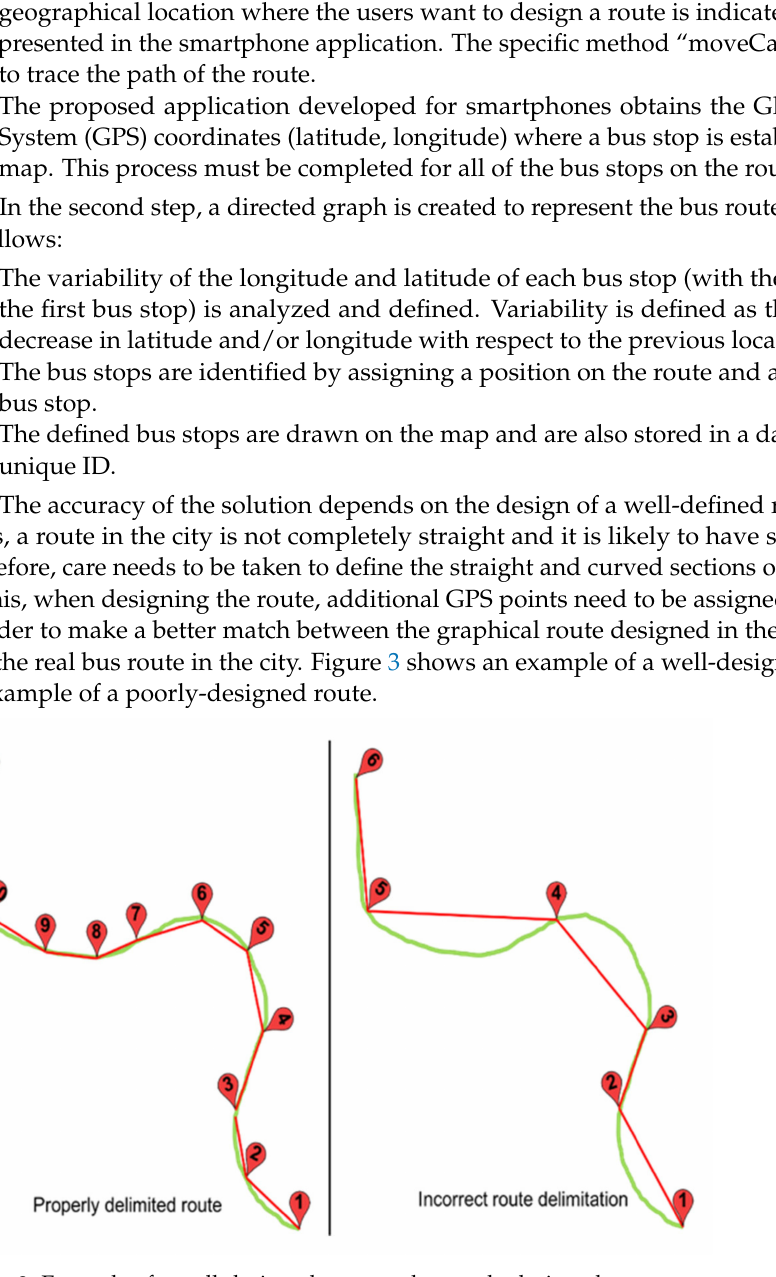
Figure 3. Example of a well-designed route and a poorly designed